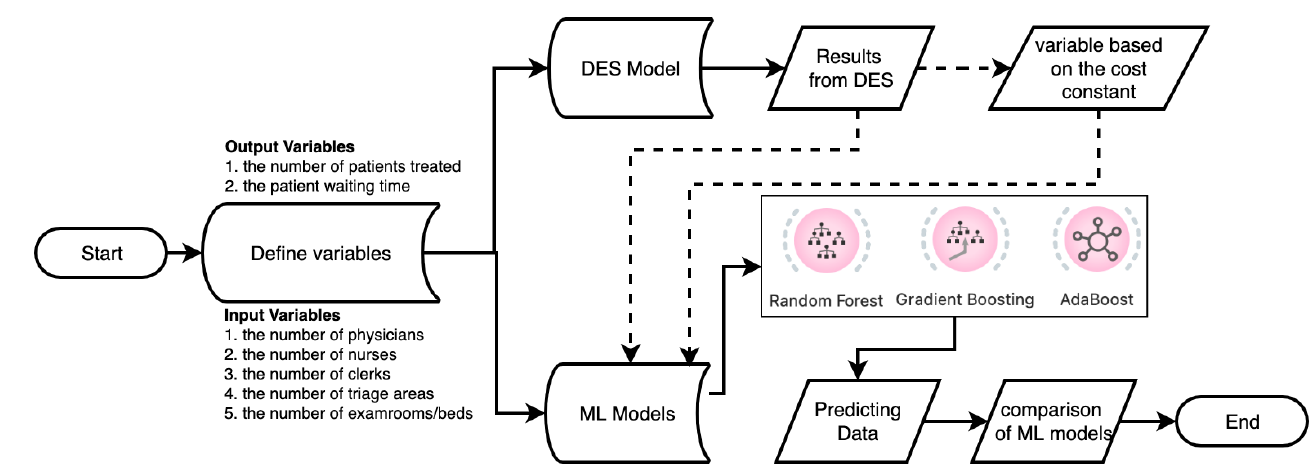
Figure 1. The flow chart of DES and ML models.